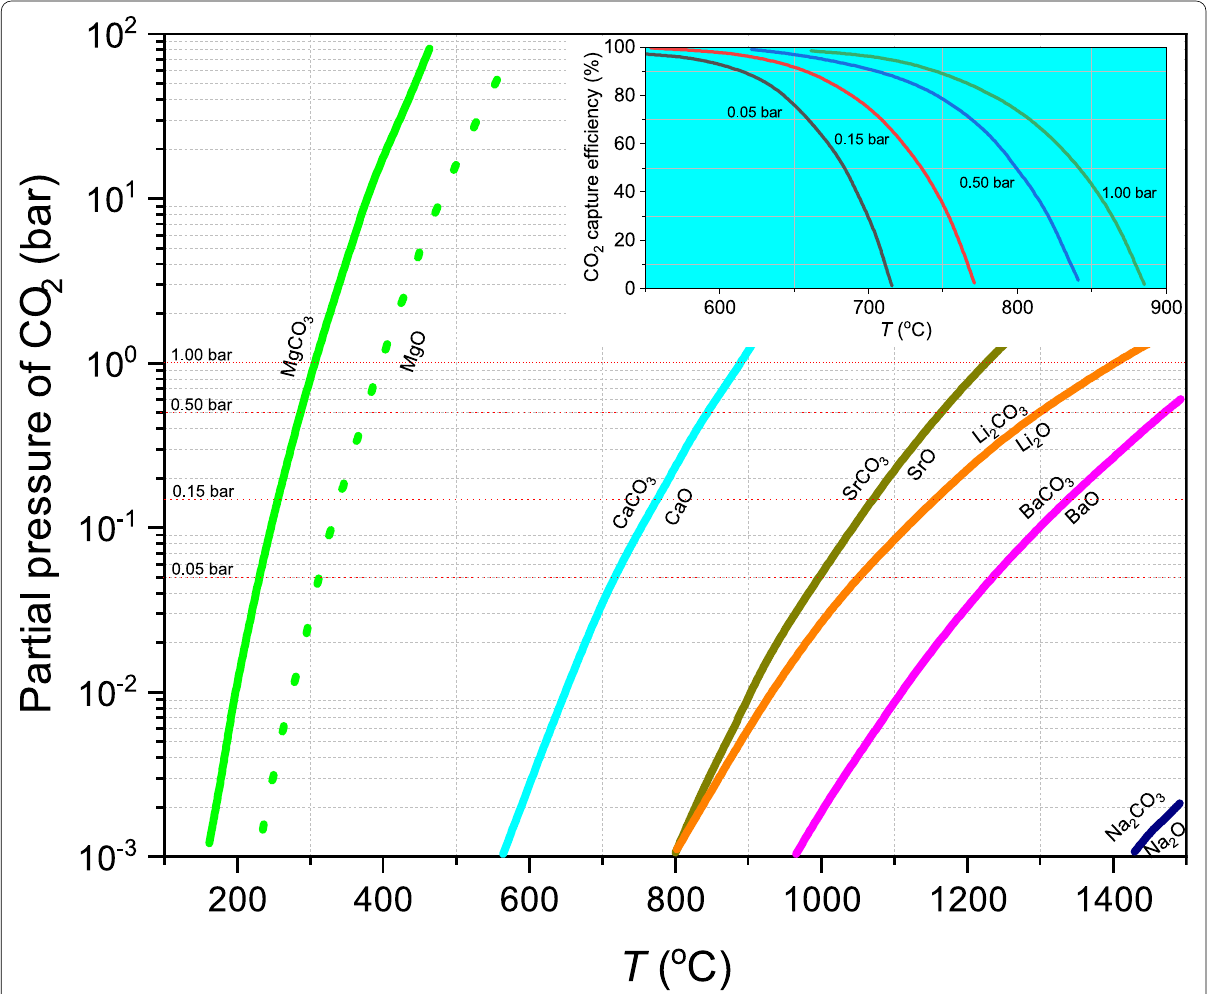
Fig. 12 Equilibrium partial pressure of CO 2 , pCO 2 ,eq, as a function of temperature for typical oxide systems [57,